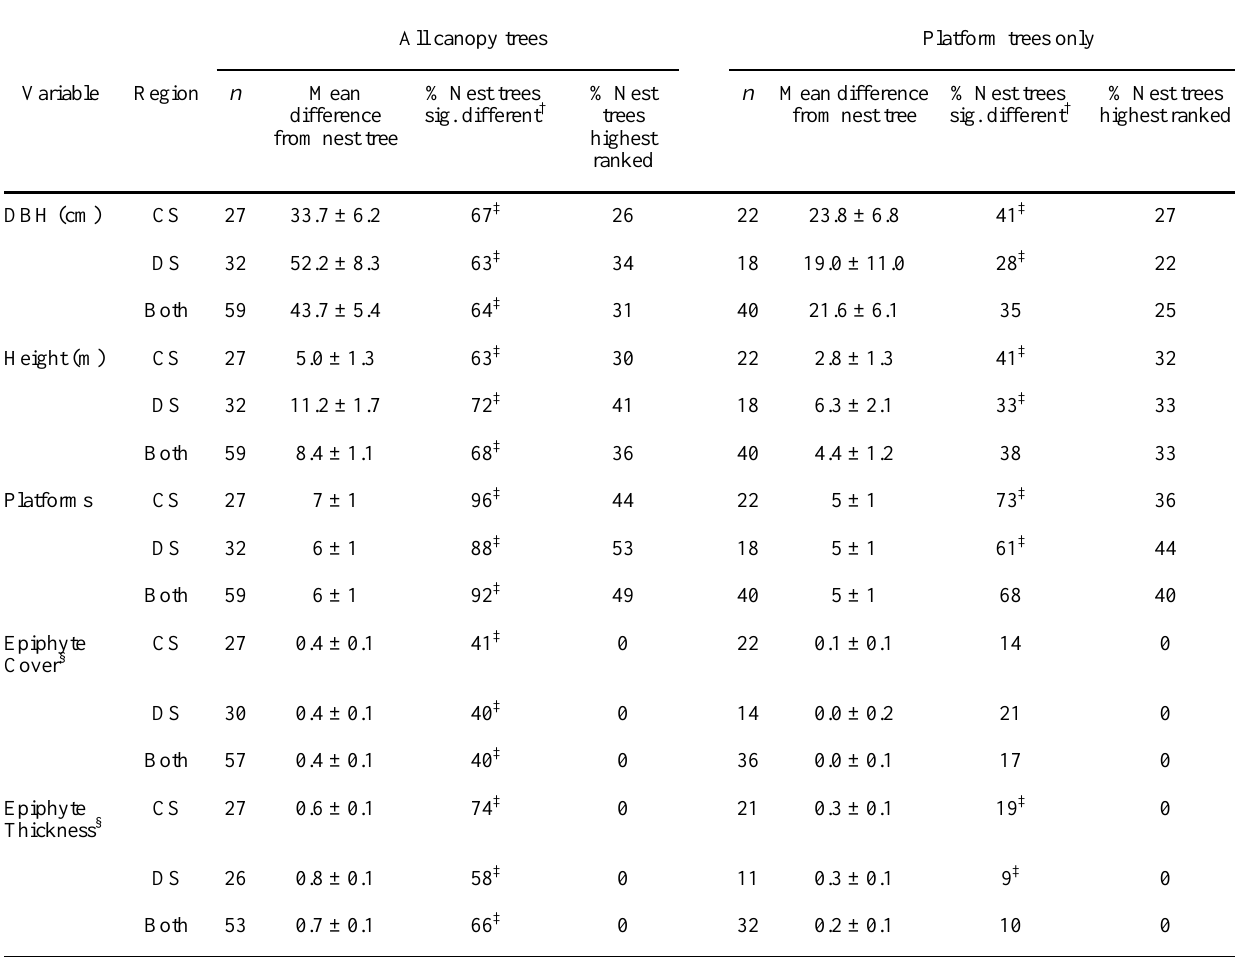
All canopy trees Platform trees